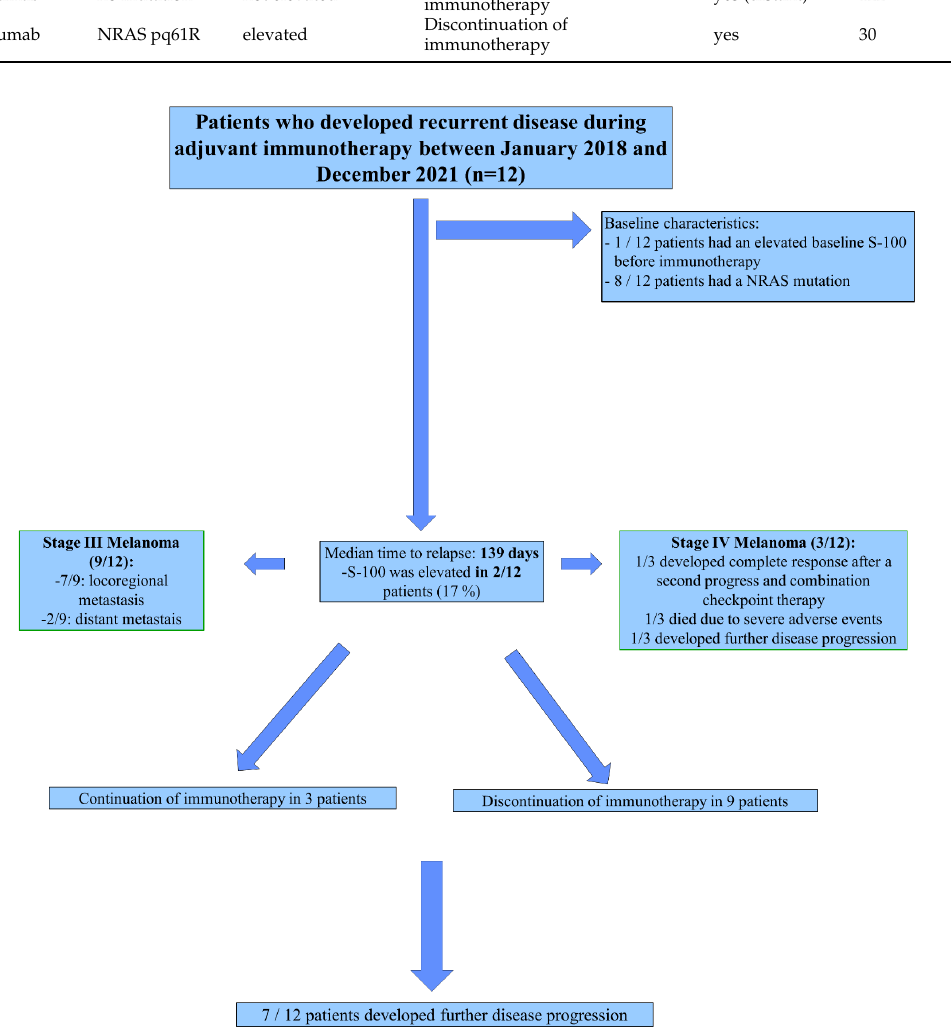
Figure 4. Flowchart overview. 2.4. Systemic Biofactors and Mutation Status at Baseline and at the Time of Recurrence Of all the patients who had recurrent disease, none had an elevated serum lactate dehydrogenase (LDH) at baseline before starting the adjuvant immunotherapy, which is also known to be associated with disease control [24]. The mean baseline percentage was 24% (+/ − 7).